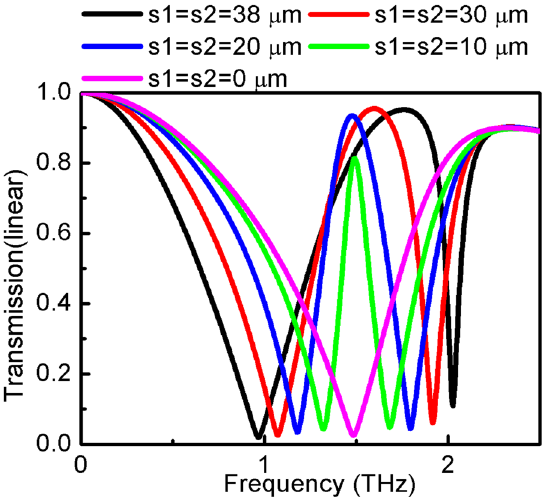
Figure 6. Compared with the transmission of different s at a = 100 μ m, b = 40 μ m, d 1 = 0.02 μ m, d 2 = 12 μ m,